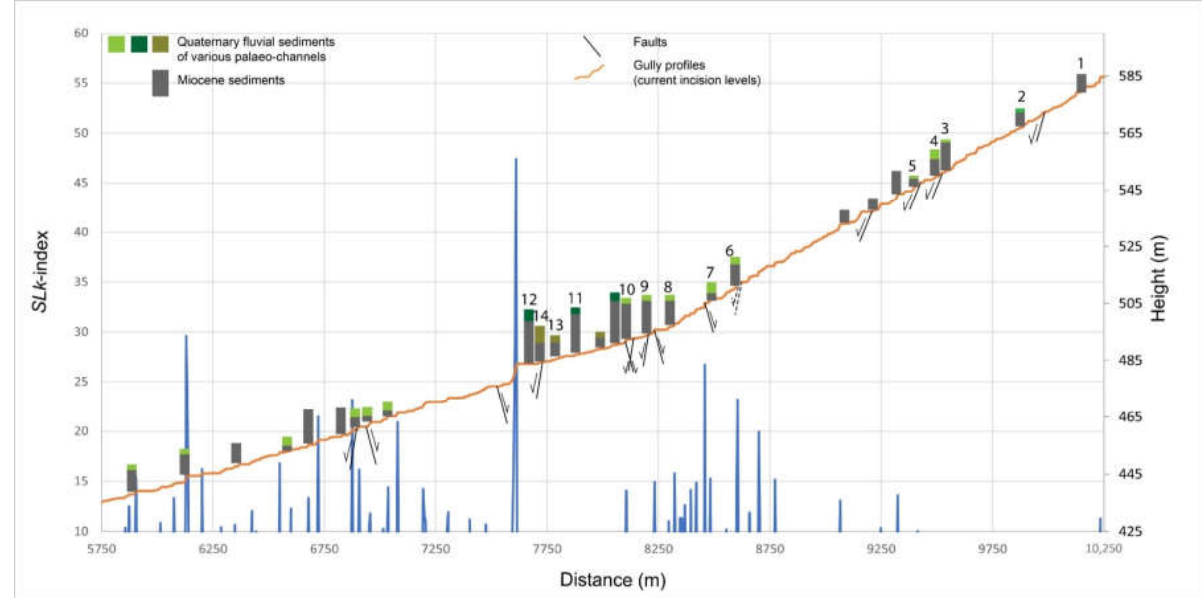
Figure 11. Stratigraphic columns of gully Z2 in Figure 5 showing correlation between eroded and deposited Quaternary sedimentary units along fault zones. Numbered stratigraphic columns are explained in Table 1. Faults are indicated with black lines between stratigraphic columns. SLk indexes for this selected gully also shown with blue lines. Modified after [90].